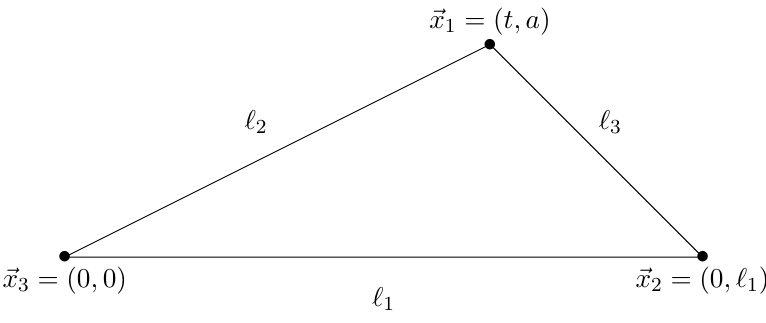
Figure 3. Simplest kinematics when the triangle inequality is violated ‘ 2 + ‘ 3 < ‘ 1 and three points are inherently